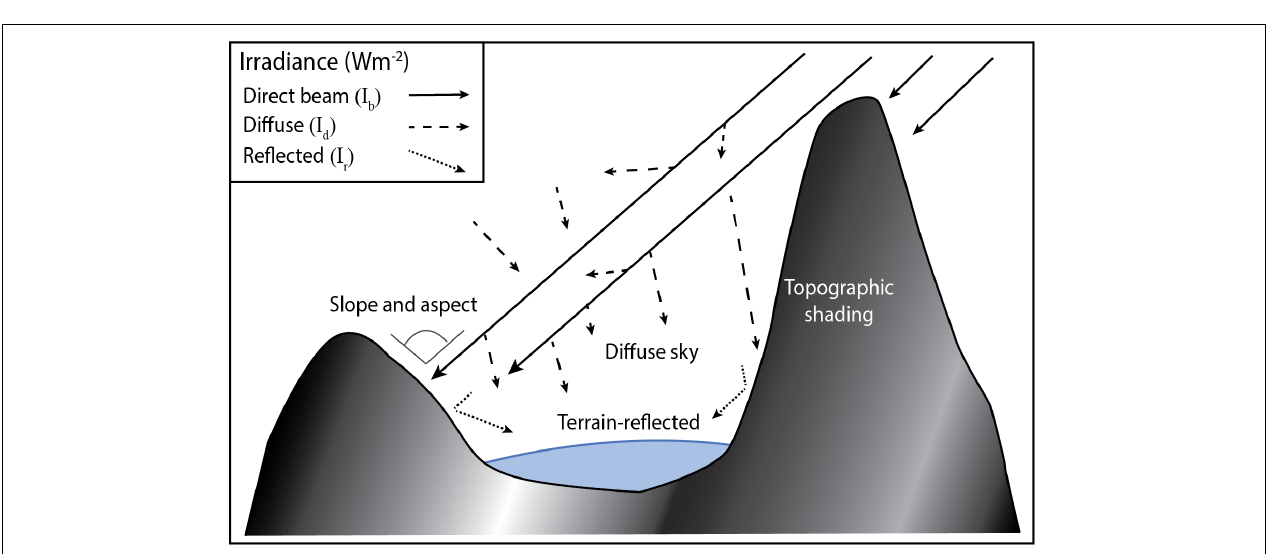
FIGURE 1 | Map of the Everest region in High-mountain Asia showing the 10 glaciers used in this study (light blue). The dark blue outlines indicate two selected glaciers, the East Rongbuk (ERG — RGI60-15.10055) and Lumsamba (LG — RGI60-15.03474), which we highlight throughout the paper. Glacier outlines from the Randolph Glacier Inventory v6.0 (RGI Consortium, 2017), basemap from Esri (2009).